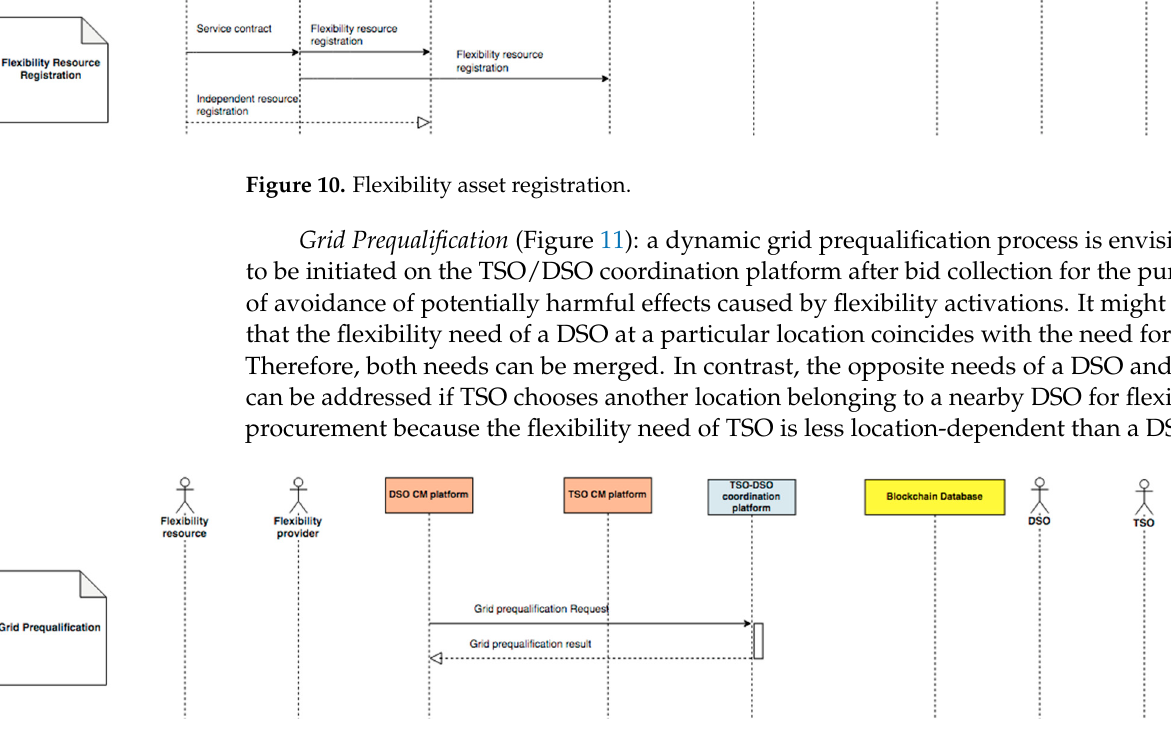
Figure 11. Grid Prequalification. Figure 11. Grid